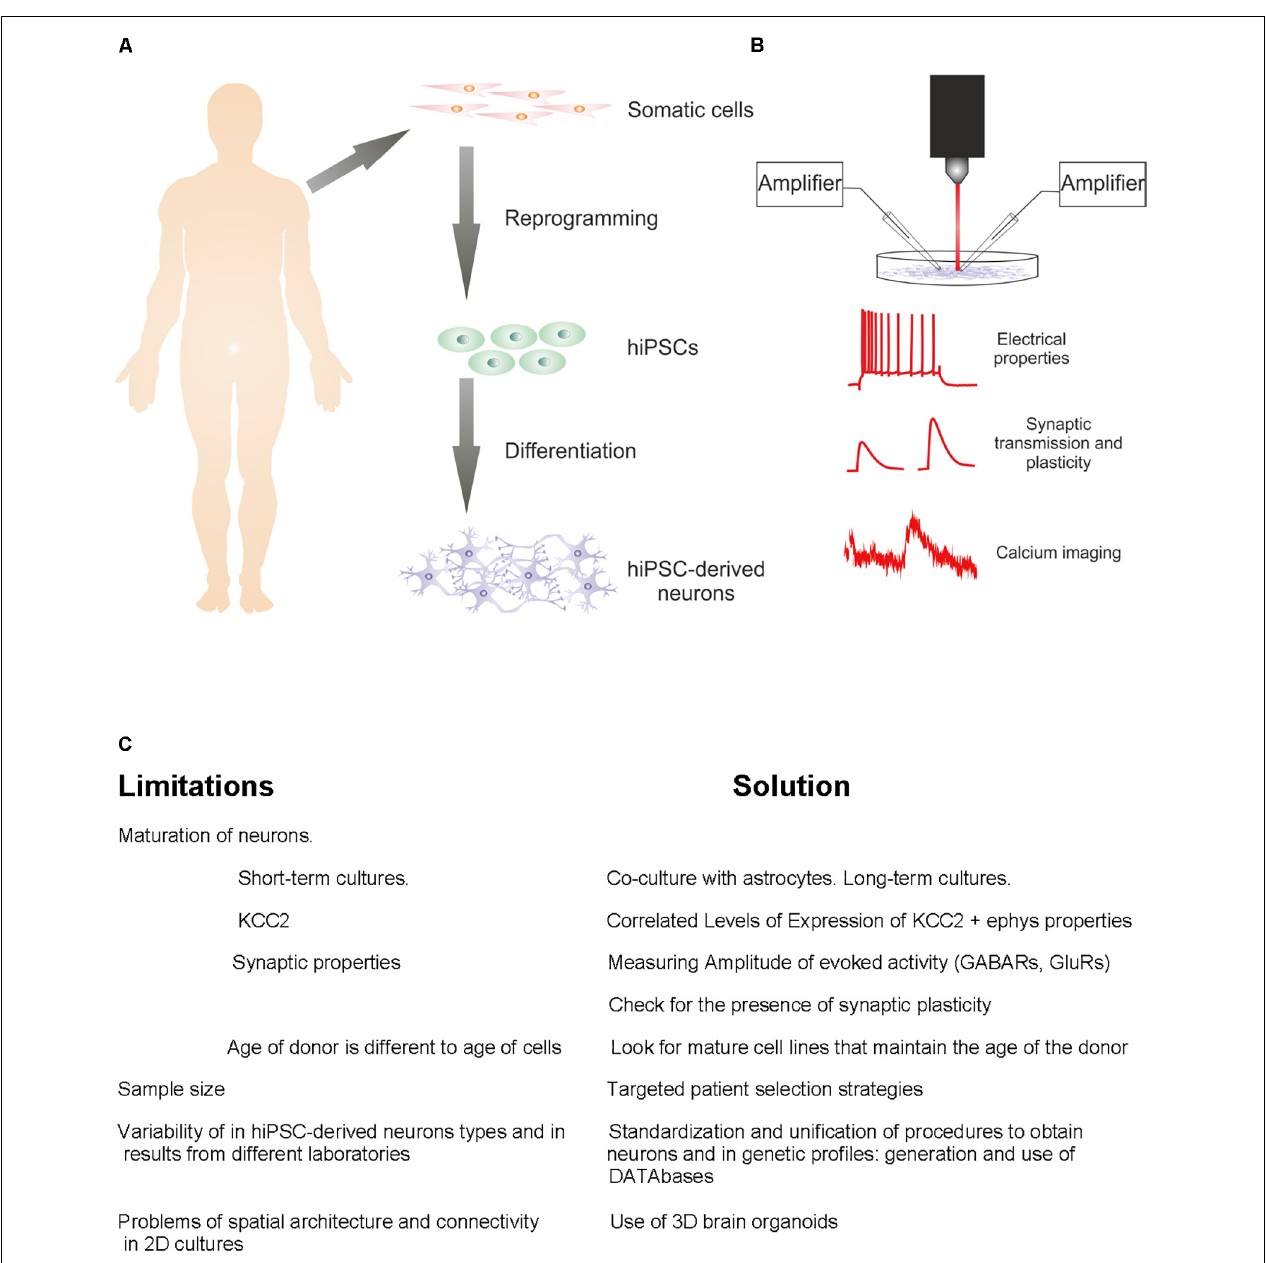
FIGURE 1 | From patient to the study of hiPSC-derived neurons. (A) Diagram of standard steps required to convert somatic cells from diseased or healthy individuals into hiPSC-derived neurons. (B) Representation of electrophysiological approaches for functional characterization of hiPSC-derived neuronal characteristics. (C) Challenges to be resolved and